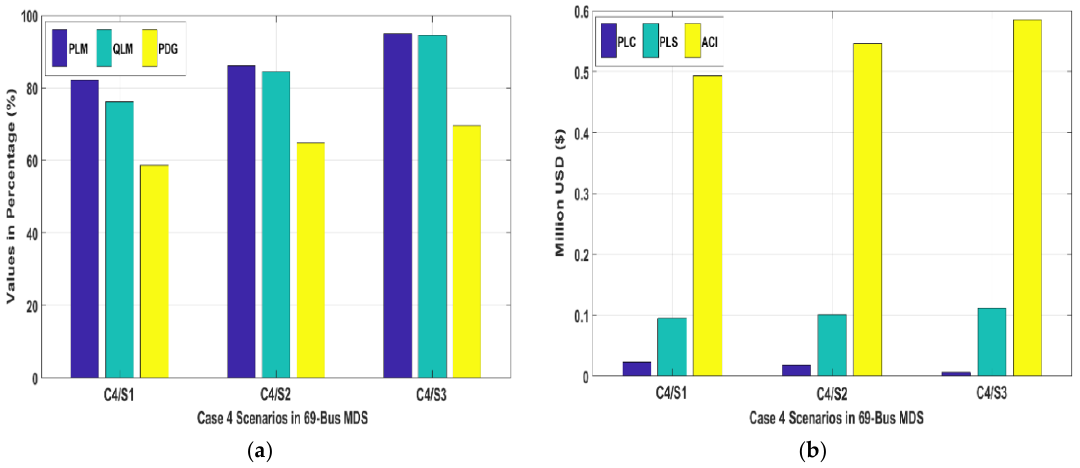
Figure 19. Case 4 Scenarios for 69-bus MDS (L_Min) ( a ) Performance evaluation in-terms of PLM , QLM and PDG ; ( b ) Performance evaluation in-terms of PLC , PLS and ACI